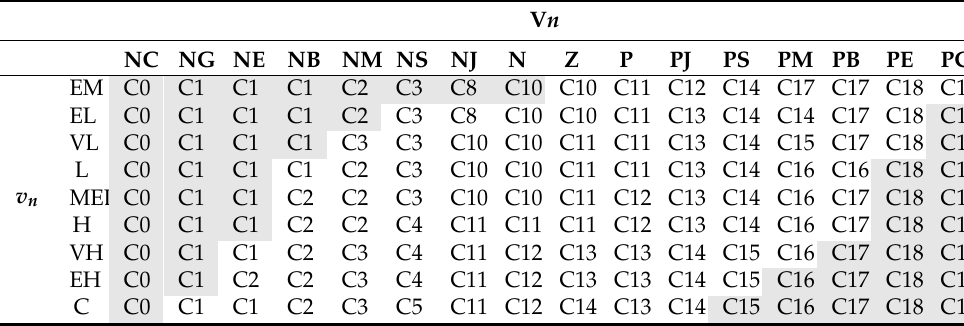
Table 1. Generated fuzzy model